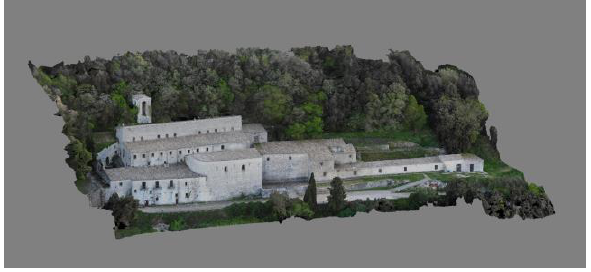
Figure 5. 3D model shadow